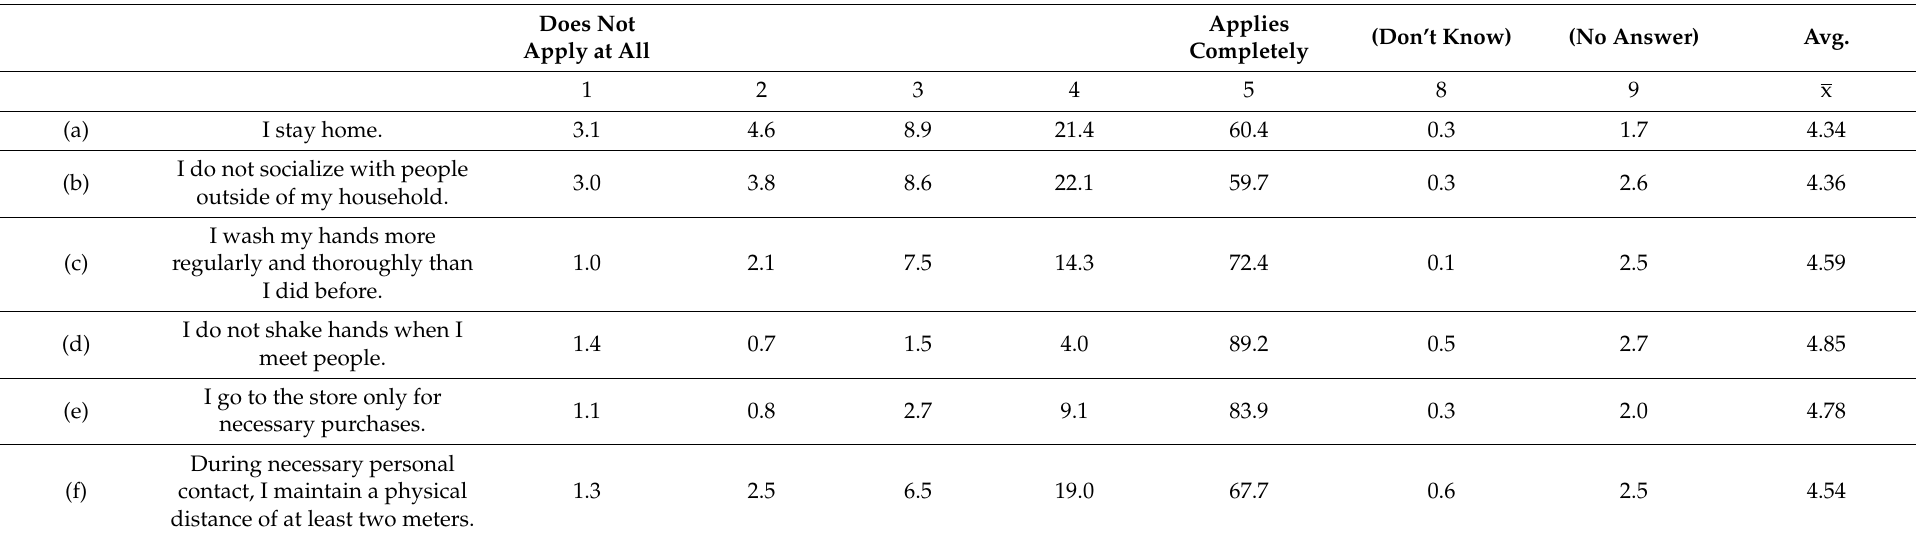
Table 1. Adherence to recommendations and rules during the